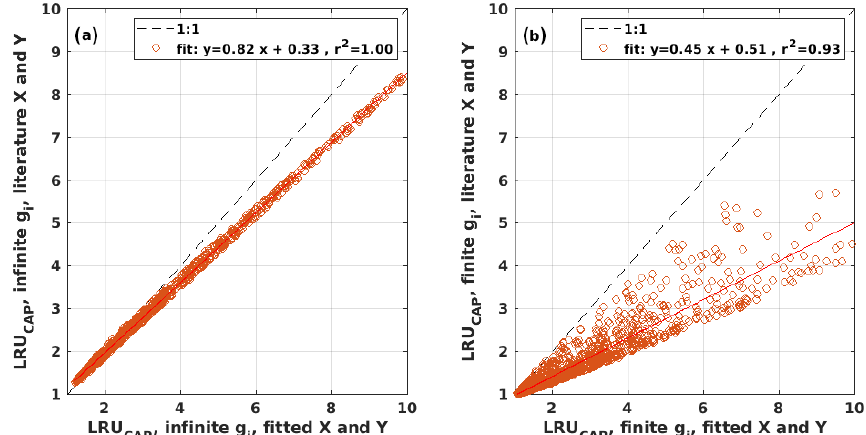
Figure B2. Scatter plots of LRU CAP using the literature values against LRU CAP using the optimized parameter values when assuming (a) infinite or (b) finite mesophyll